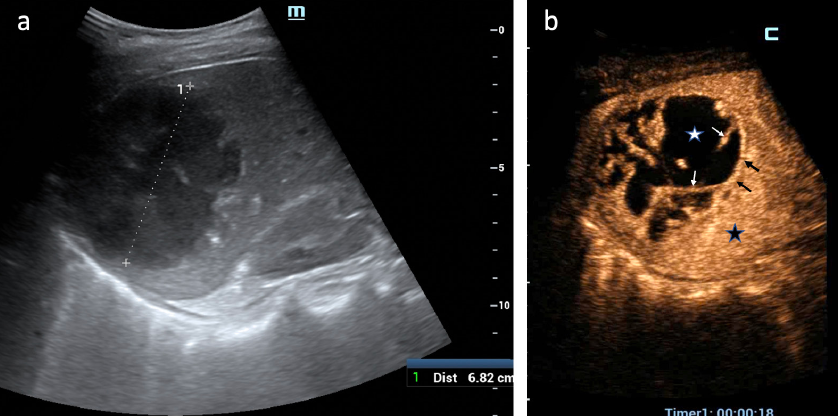
Figure 2. CEUS findings in PLA (arterial phase). (a) A 7-cm PLA is displayed in the right liver lobe at US B-mode; (b) TSE (black star) surrounds PLA; a thin PHR (black arrows) delimits abscessed cavity where irregular non-enhanced areas of liquefaction (white star) are separated by hyperenhancing septa (white arrows). Based on CEUS demonstration of communication between the multiple liquified cavities, the operator confidently positioned a single 8-F catheter to drain PLA